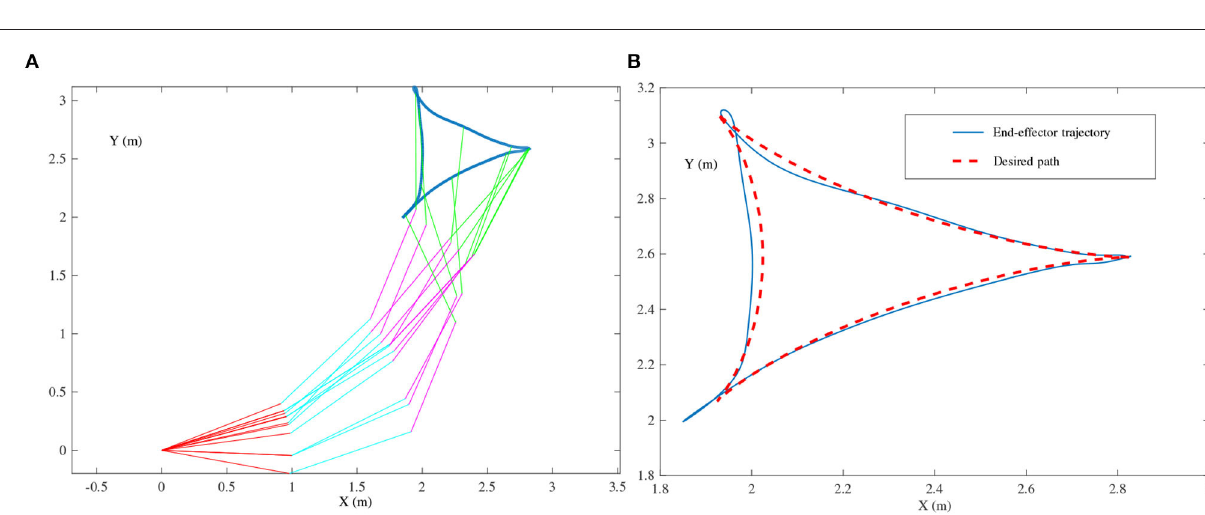
FIGURE 8 | End-effector of the four-link planar robot manipulator tracking the tricuspid path synthesized by the noise-polluted kinematic control method in (29) using τ = 10, where single-harmonic noise is considered. (A) Simulated motion trajectories. (B) Path and